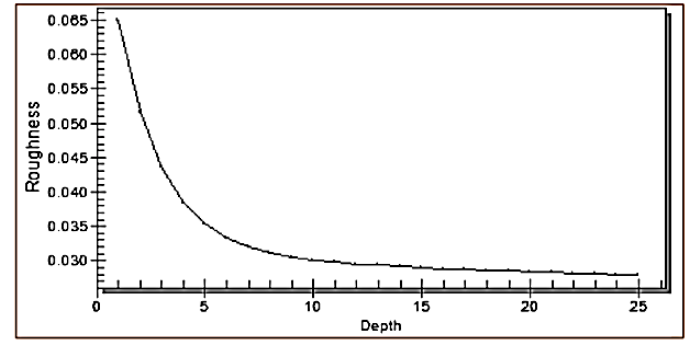
Figure 3. Manning’s roughness coe ffi cients of the Al-Hammar Marsh [34].